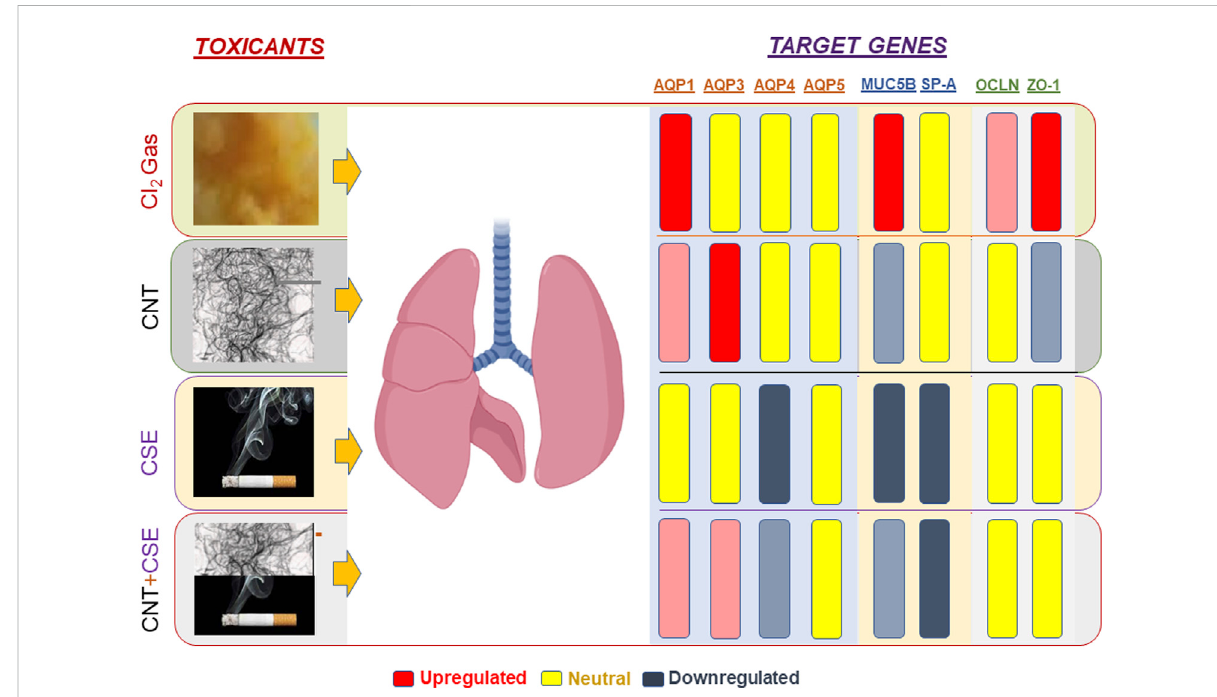
FIGURE 5 Schematic representation of toxicant-speci fi c target gene expression patterns in exposed mouse lungs. The toxicants tested are shown on the left-hand side of the lungs whereas the target genes quanti fi ed are shown on the right-hand side. Gene regulation pattern is color coded as follows: Upregulation(red),Downregulation(blue-gray),NeutralorUnchanged/Statistically non-signi fi cant(yellow). Theextentofregulation(foldchange)is re fl ected by the color